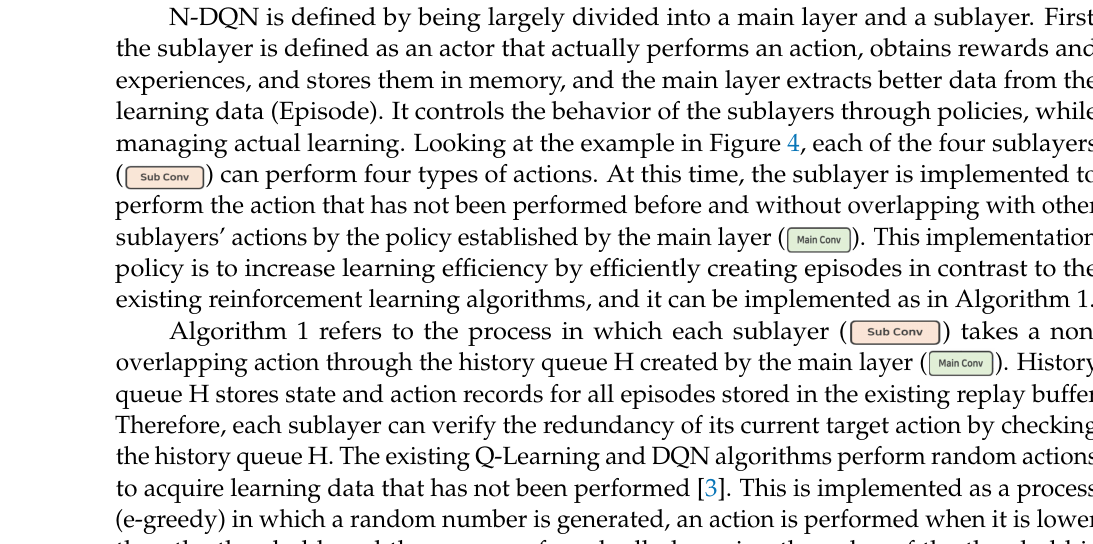
Figure 4. Architecture of the proposed multi-agent